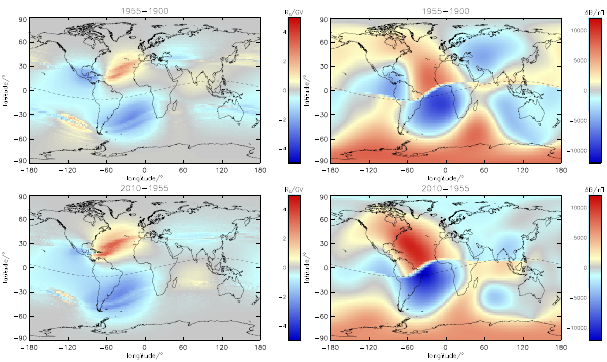
Fig. 4. Same as Fig. 3 but for the intervals 1900 to 1955 (upper panels) and 1955 to 2010 (lower panels)